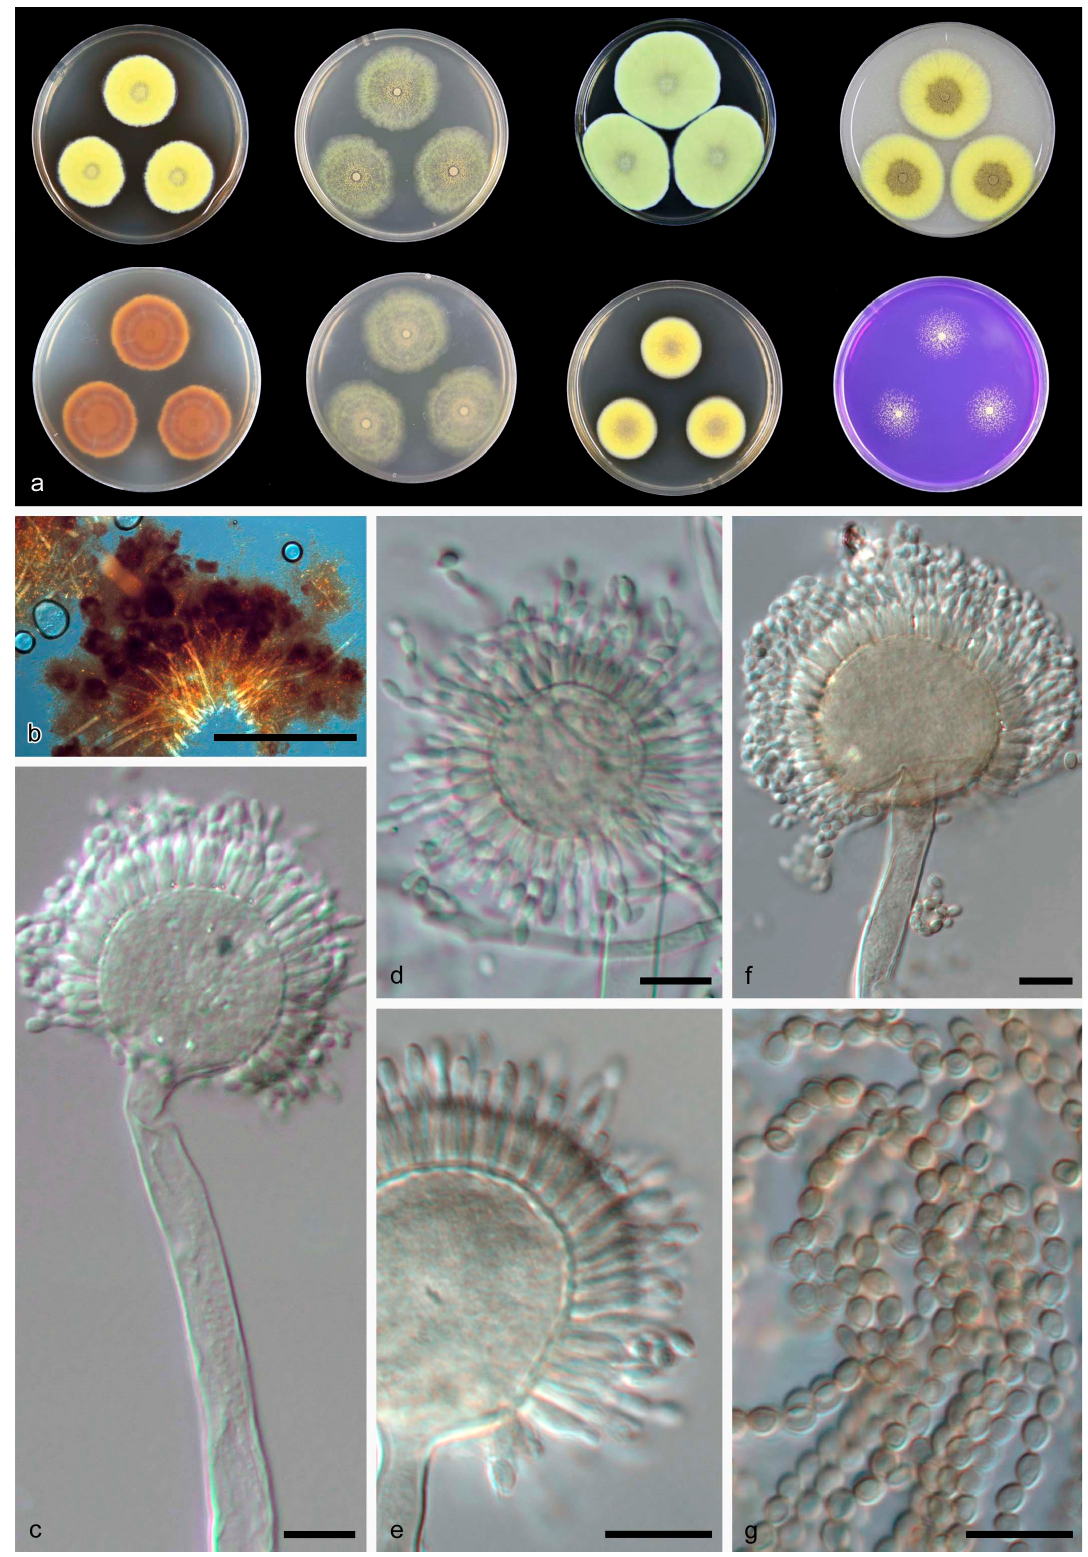
Figure 2. Aspergillus guangdongensis CGMCC 3.19704 T. ( a ) Colonies: top row left to right, obverse CYA, obverse MEA, YES and OA; bottom row left to right, reverse CYA, reverse MEA, DG18 and CREA. ( b – f ) Conidiophores. ( g ) Conidia. Scale bars: b = 500 μ m; c–g = 10 μ m.